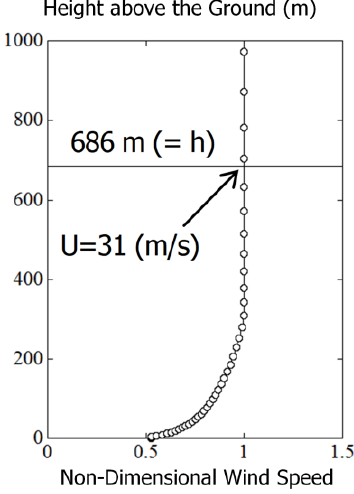
Figure 9. Inflow wind velocity profile.